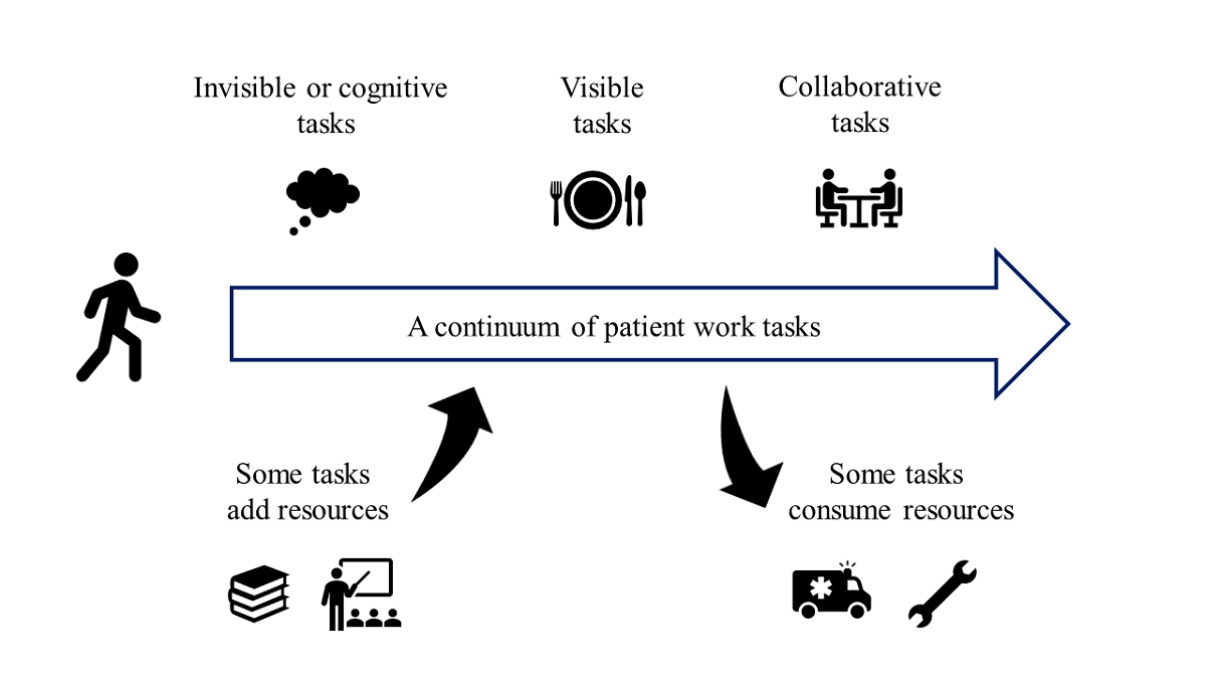
Figure 4. A continuum of patient work tasks that the patient moves through in their illness